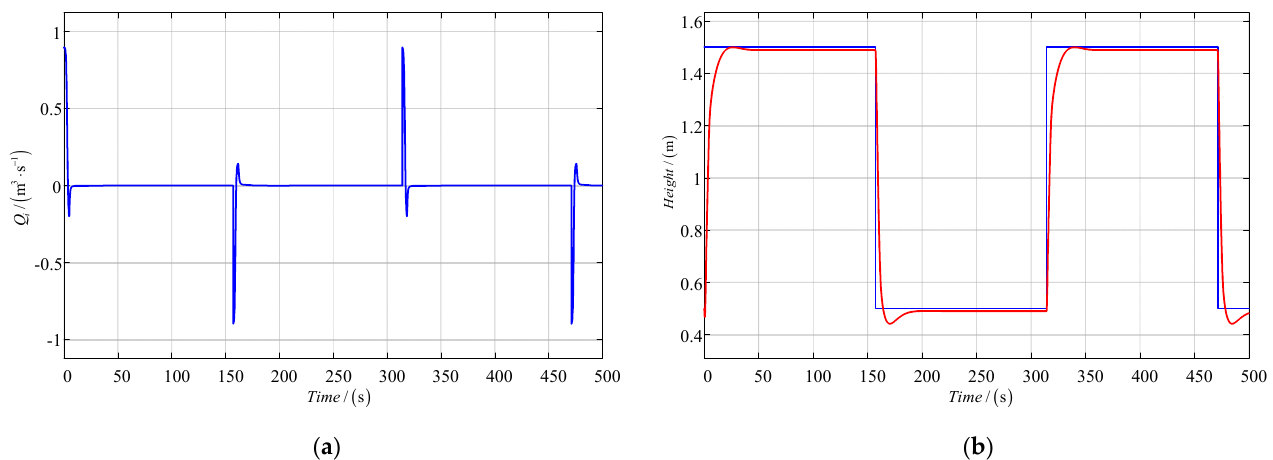
Figure 11. Limited inflow rate feedback fuzzy control simulation results: ( a ) represents the control input curve ( b ) represents the water level curve. Table 1. Comparison of the Closed Loop